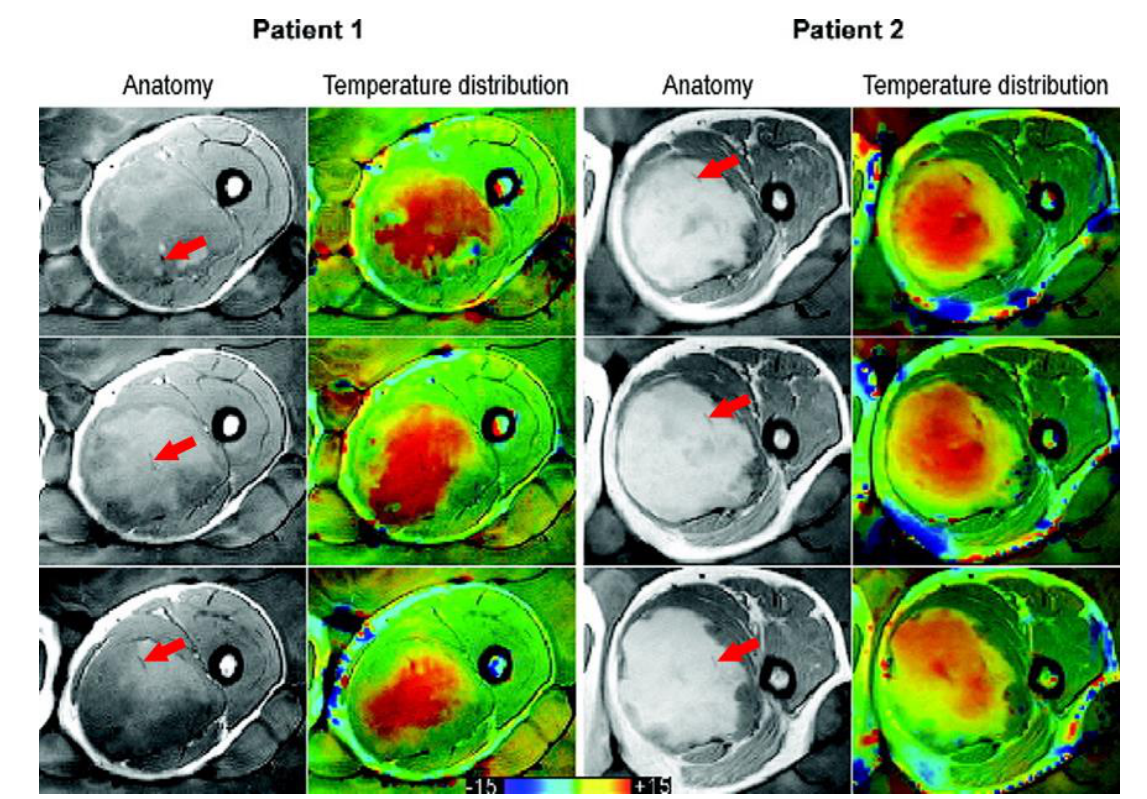
Figure 1. Taken from Gellermann et al. [21] and re-printed with permission from John Wiley and Sons. Example of anatomy with thermal mapping catheters (red arrows) for two patients with corresponding MR temperature distributions for three different slices. The images were acquired with a T1-weighted gradient-echo sequence. (The arrows were superimposed on the original image for clarity.)